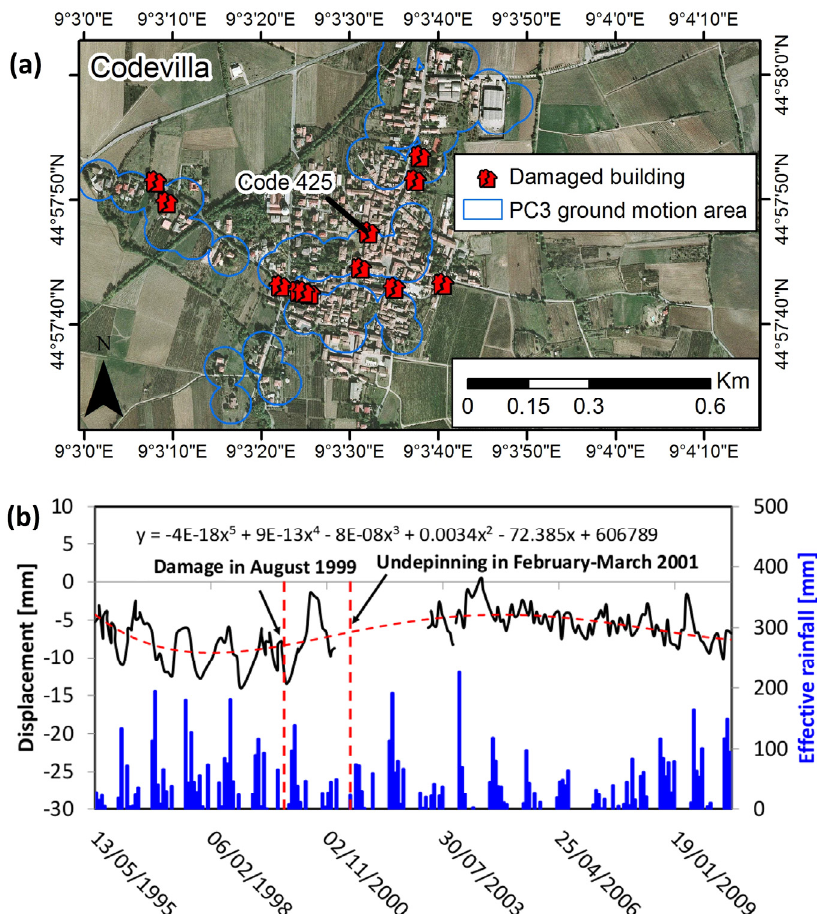
Figure 10. ( a ) Ground motion areas in Codevilla, detected by the ERS-1/2 and Radarsat PC3, and the distribution of damaged buildings detected by Meisina et al. (2006) [30]. ( b ) Average LOS displacement time series in the buffer zone of 100 m from the damaged building (code 425) versus effective rainfall measured at the Voghera weather station. The dotted red line is the polynomial regression trend (5° order) of the displacement time series. The equation for polynomial regression has been also indicated.